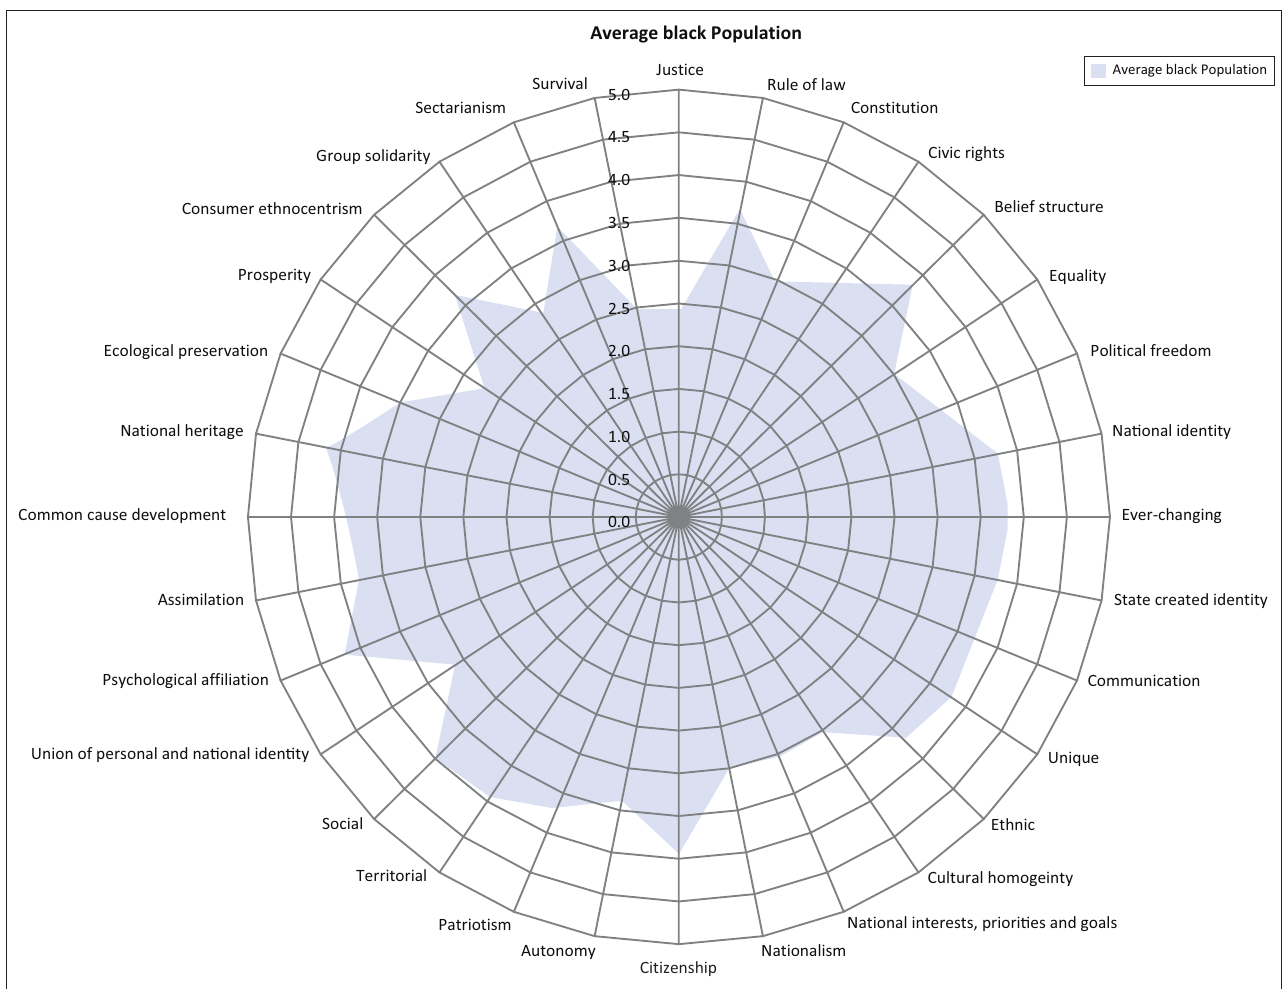
FIGURE 3: Spidergram depicting the extent of the indicators of national identity (black